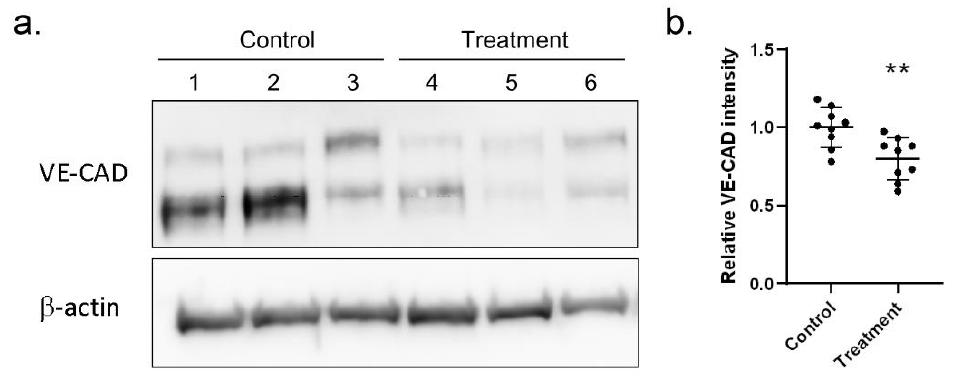
Figure 3. Western blot assay demonstrated reduced VE-CAD proteins with S100A4 treatment on HCAECs. We used a Western blot assay to examine whether S100A4 treatment (45 pg/mL) reduced the abundance of cell junction proteins (VE-CAD) on HCAECs. ( a ) One round of Western blot assay result (three replications). ( b ) By three independent rounds of assay (three rounds * three replications), a significant difference was reached. Data were presented as mean ± SD. ** denoted p -value < 0.01. VE-CAD—vascular endothelial cadherin protein; HCAECs—human coronary artery endothelial cells; S100A4—S100 calcium-binding protein A4.